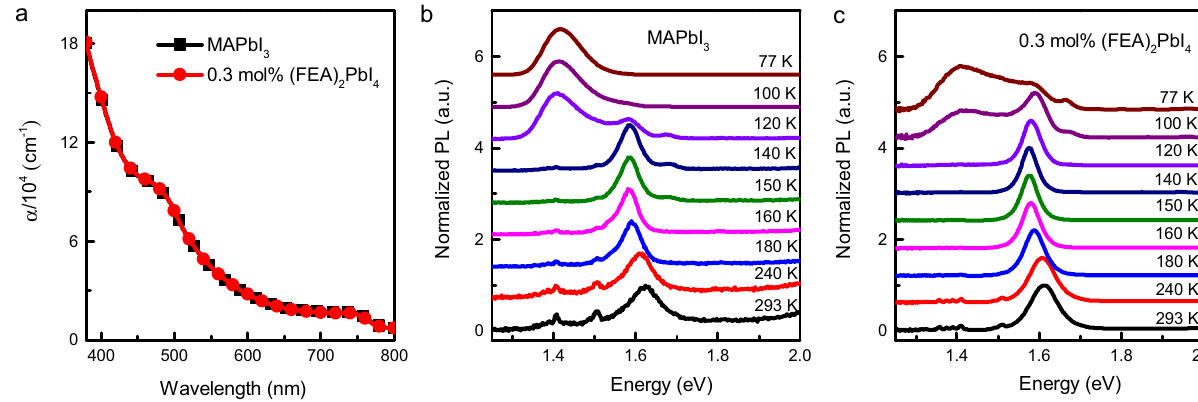
Fig. 3 Photophysical properties of the neat MAPbI 3 and 0.3 mol% (FEA) 2 PbI 4 -containing fi lms. a Absorption spectra on glass ( α = absorption coef fi cient). b , c Temperature-dependent ( K = Kelvin) photoluminescence (PL) spectra ( λ exc = 550 nm) on fused